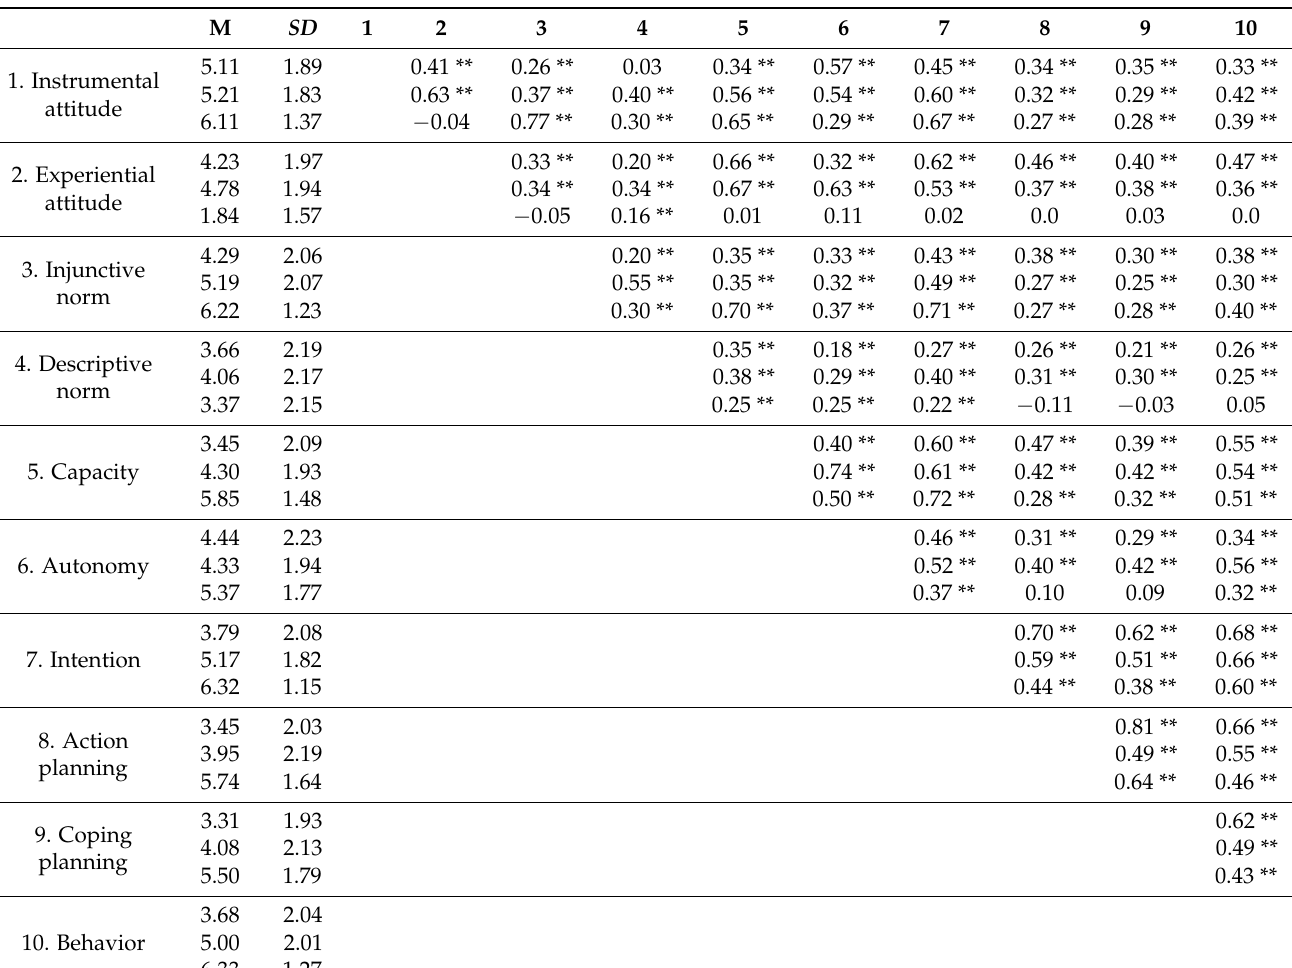
Table 1. Bivariate correlations between RAA constructs, planning, and physical activity, diet, and glucose monitoring (N =